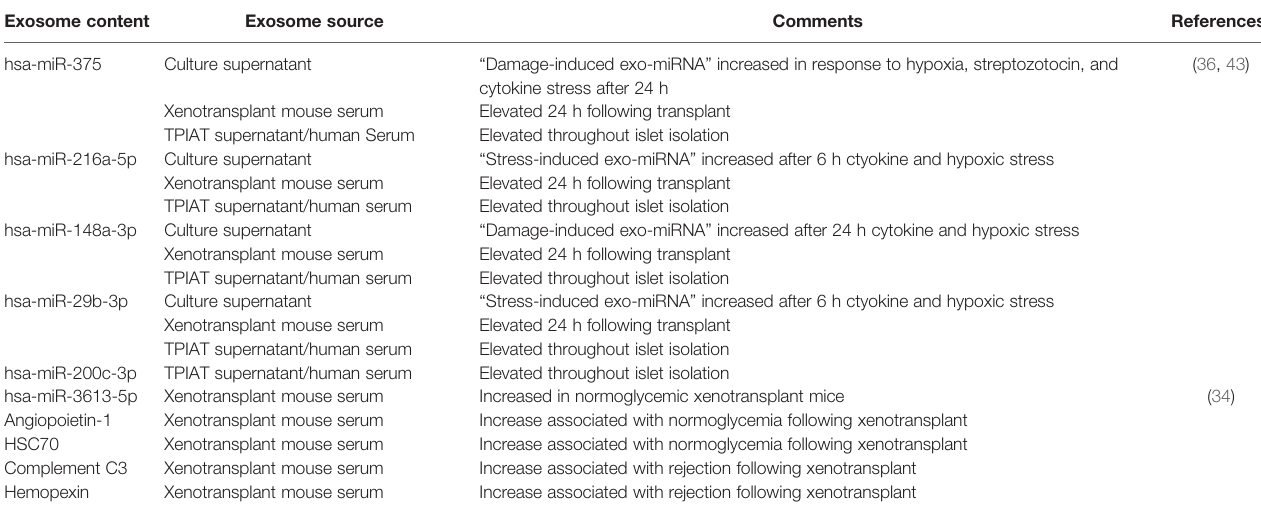
TABLE 1 | Exosomal cargo in human islet